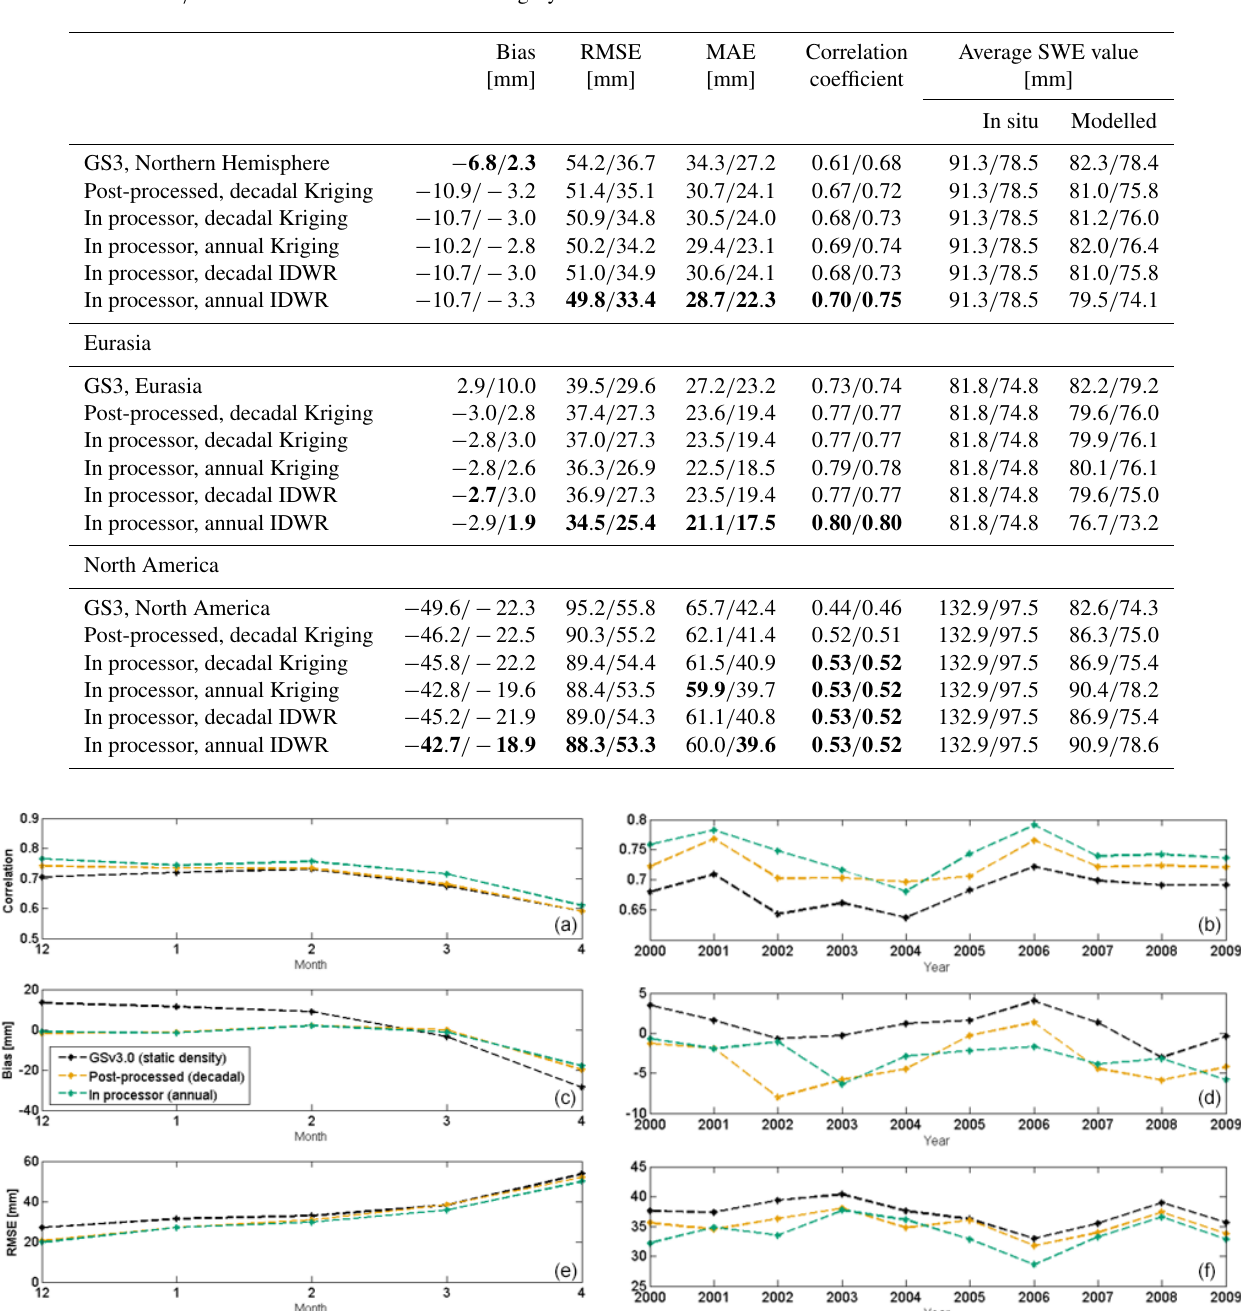
Table 3. Summary of validation parameters for GSv3.0, post-processed product, and different densities in the retrieval products for 2000– 2009 for SWE < 500 / 200mm. The best value in each category is in bold.